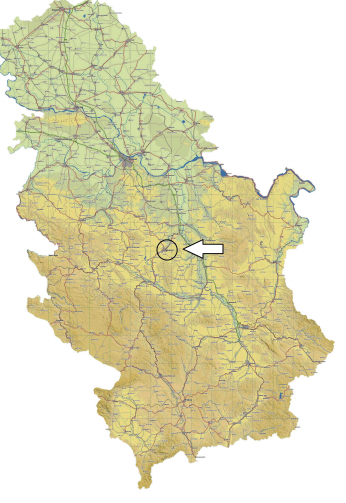
Figure 1. Geographical position of the City of Kragujevac in Serbia indicated by a white arrow (http://www.autoportal.rs/news/Image/geografska-karta- srbije.jpg)